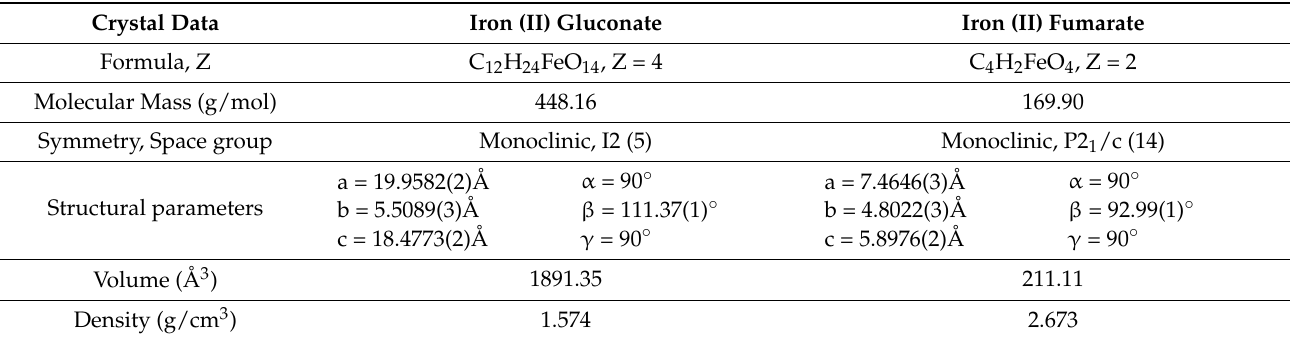
Table 1. The crystal data obtained for iron (II) gluconate and iron (II) fumarate. Crystal